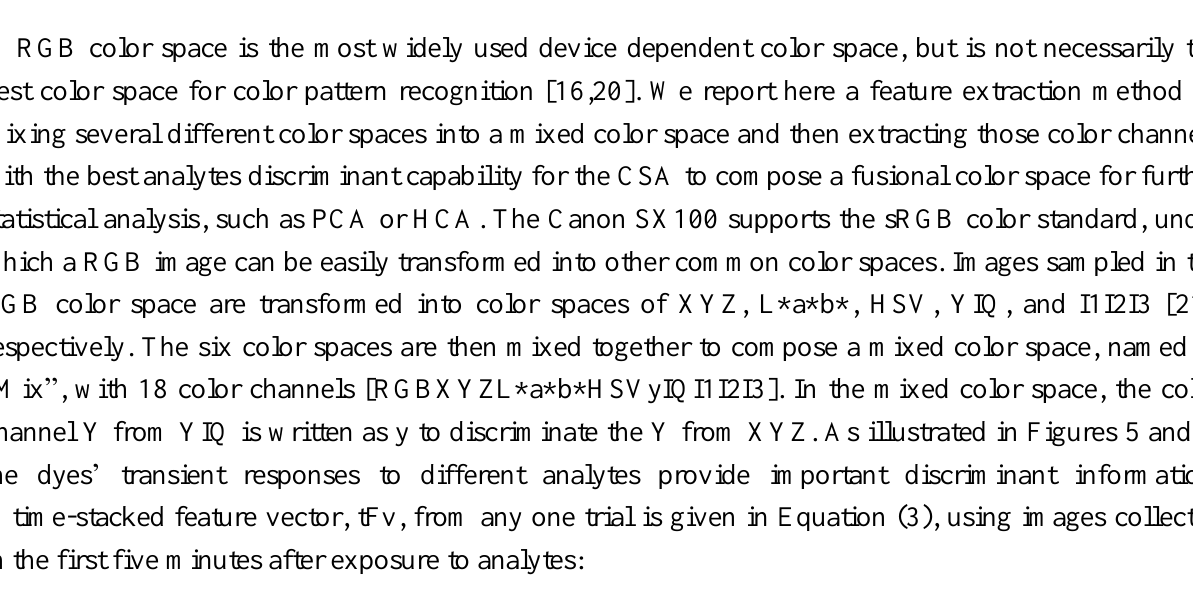
to 2 ppm (dotted line) and 2